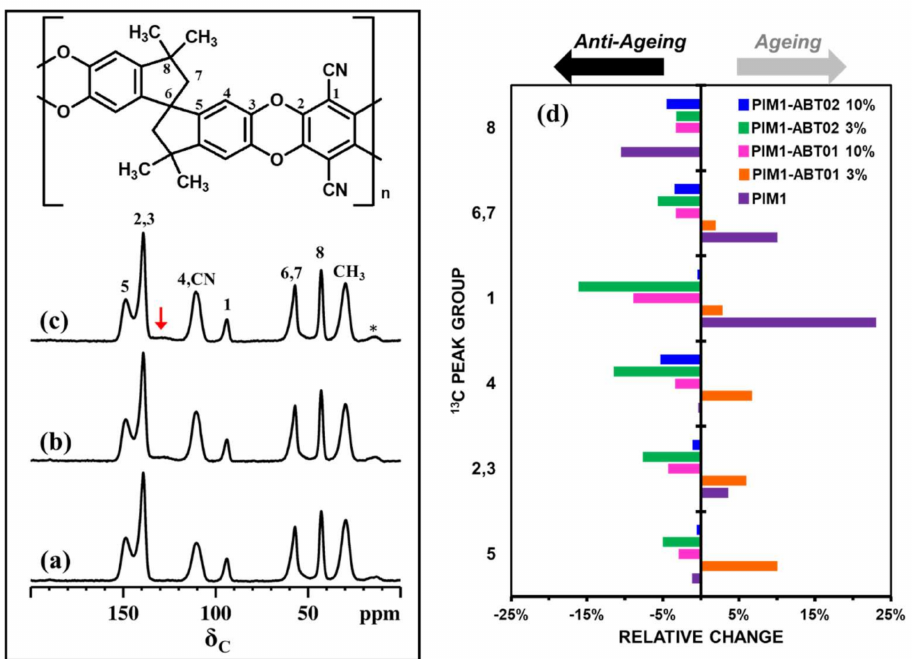
Figure 10. 13 C CPMAS NMR spectra of various PIM-1 based membranes: PIM-1 ( a ), PIM1-ABT01 10% ( b ) and PIM1-ABT02 10% ( c ). The spectra were recorded using a magic angle spinning (MAS) rate of 12 kHz and a CP contact time of 10 ms. * Denotes spinning sidebands. Bar chart ( d ) representing percentage changes in T 1 relaxation times of chemical groups assigned in ( c ) between t 12 (1-year aging) and t 0 (MeOH